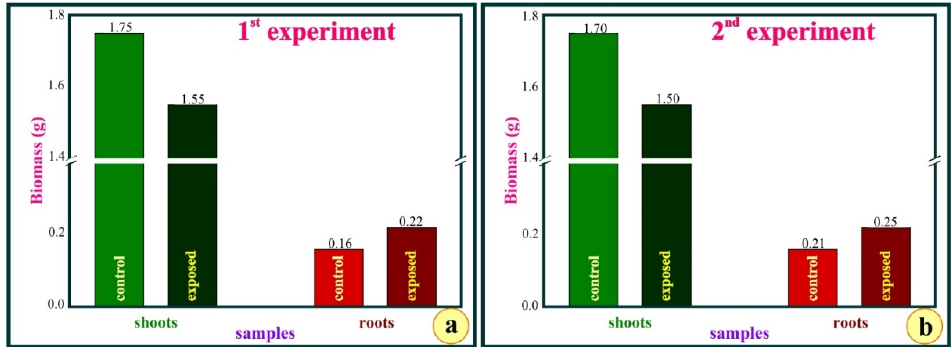
Figure 3. Biomass for the two groups of plants ( a ) after the first experiment (left): the aboveground parts of the exposed plants (shoots) presented 12% lower productivity, while the roots appeared to be 37% higher in biomass compared to their control counterparts. ( b ) After the second experiment (right): the aboveground parts of the exposed plants presented 14% lower productivity, while the roots were 20% more productive in biomass.